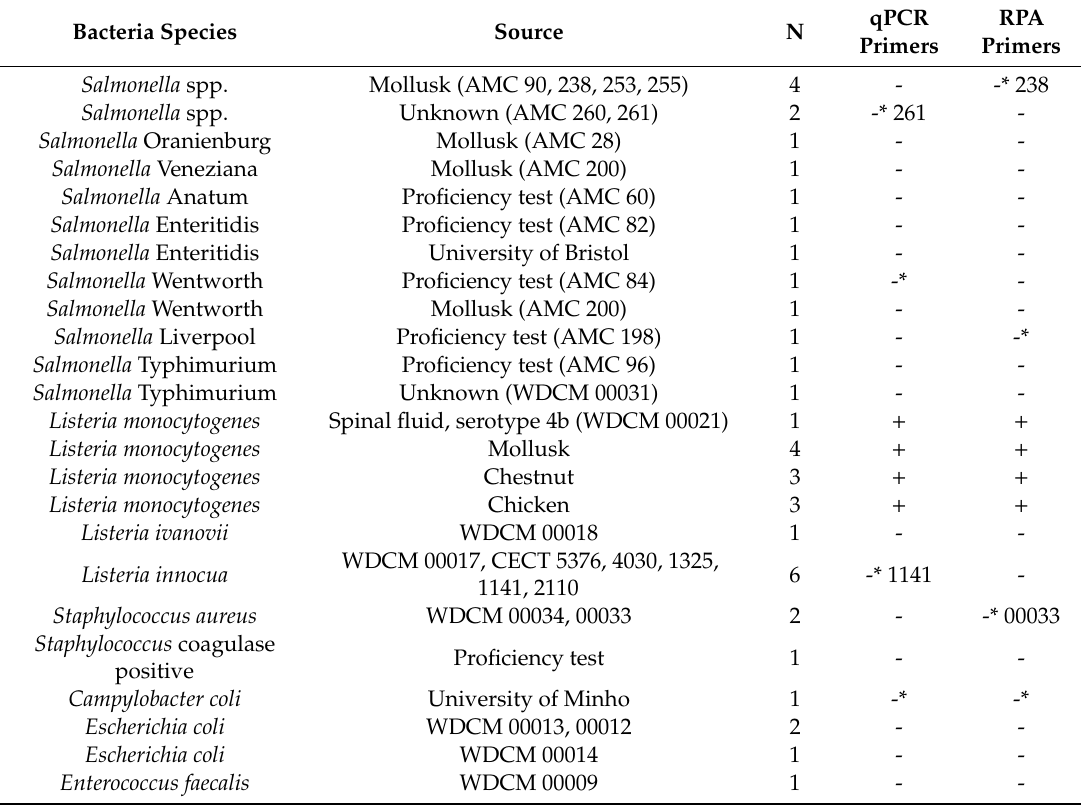
Table 1. List of bacterial strains used, and results obtained, to evaluate the inclusivity / exclusivity of two sets of